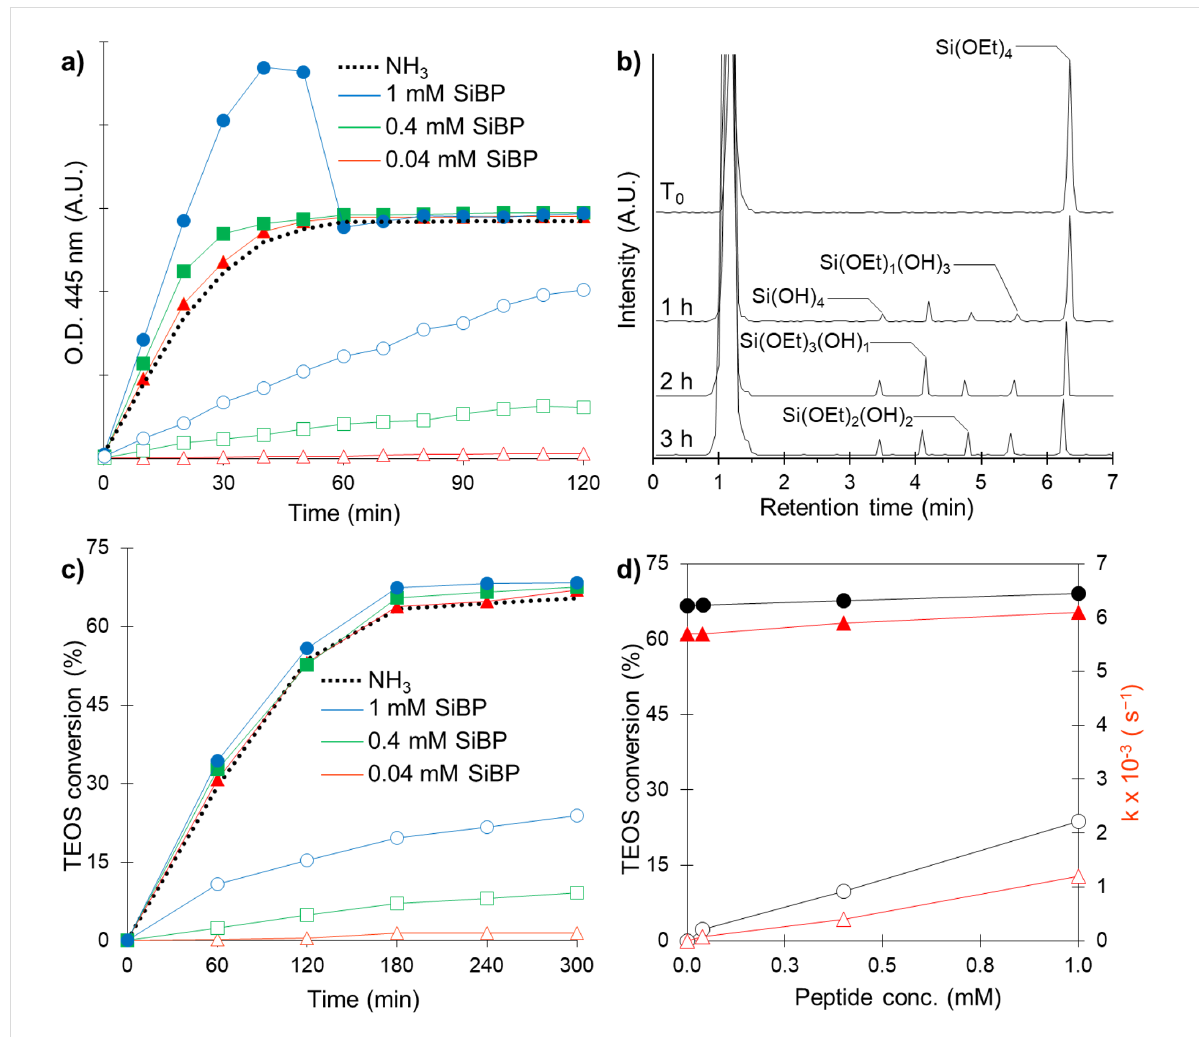
Figure 1: (a) OD profiles of particle formation (dashed line: no SiBP, empty markers: SiBP alone, solid markers: SiBP + 0.45 M NH 3 ). (b) GC spectra of the control (NH 3 only) group at different time points. (c) TEOS hydrolysis rates (dashed line: no SiBP, empty markers: SiBP alone, solid markers: SiBP + 0.45 M NH 3 ). (d) Effect of peptide concentration on reaction rate and yield (circles: TEOS conversion at 120 min, triangles: rate constant, empty markers: SiBP alone, solid markers: SiBP + 0.45 M NH 3